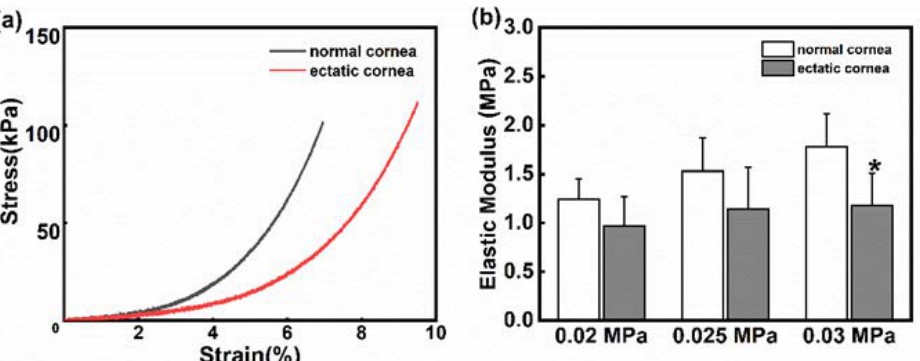
Figure 8. ( a ) The stress–strain curves of the normal cornea (gray line) and the ectatic cornea (red line); ( b ) Changes in the elastic modulus in the normal cornea and ectatic cornea at different stress levels. * p < 0.05 vs. normal cornea.